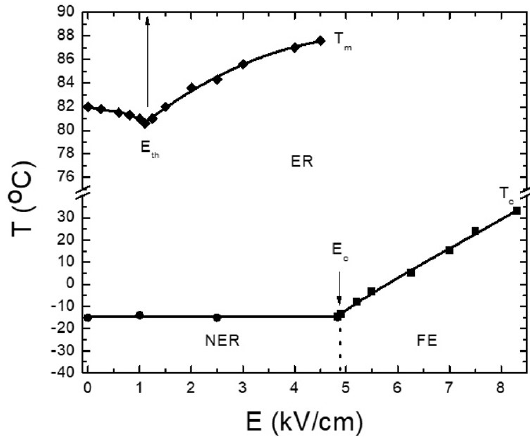
Figure 1. A plot of the T - E phase diagram of 9/65/35 PLZT ceramics: constructed from Ref. 6 (lower curve) and detected in the present work (higher curve).